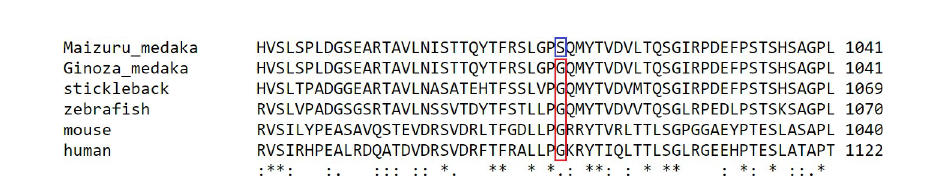
, and F generations. 1 2